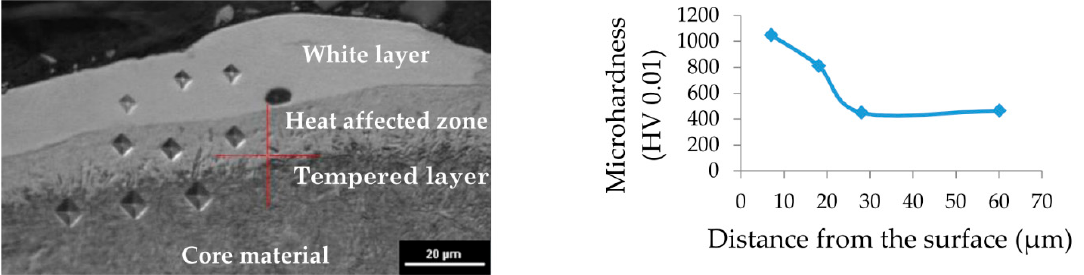
Figure 8. Metallographic structure of tool steel 55NiCrMoV7.